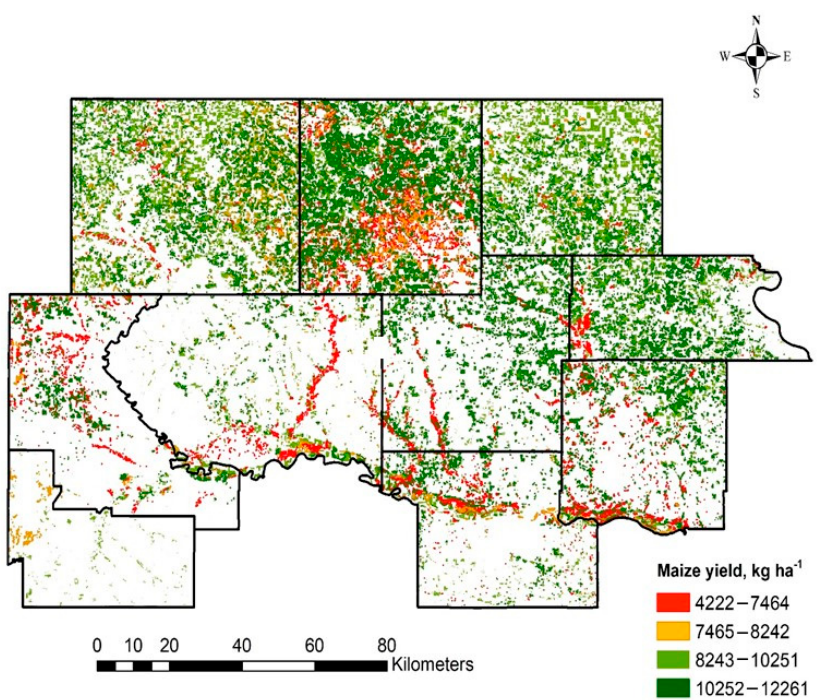
Figure 6. Variation of maize yield due to the spatial distribution of soils in the ten rainfed maize- producing counties of northeastern Kansas (dark green areas on the map indicate higher simulated maize yields, whereas red color shows areas with extremely low yields).